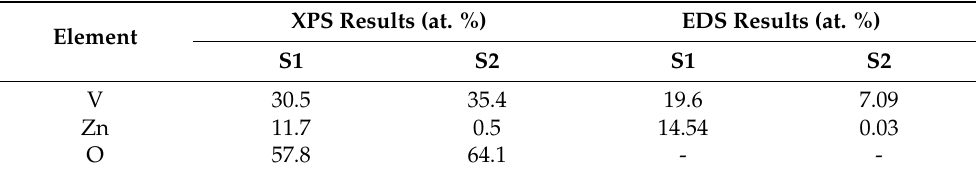
Table 1. Elemental content of sample S1 and S2 based on the XPS and EDS results.